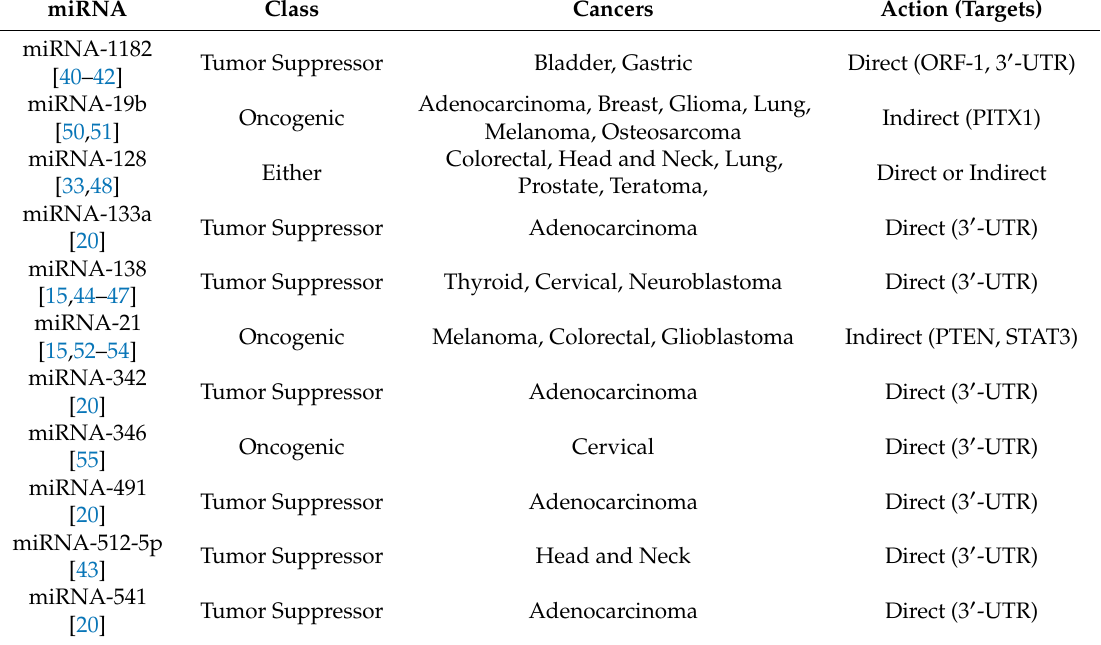
Table 1. A list of important hTERT-targeting tumor suppressor and oncogenic miRNAs, including which cancers each has been studied in and the specific mechanism of action targeting